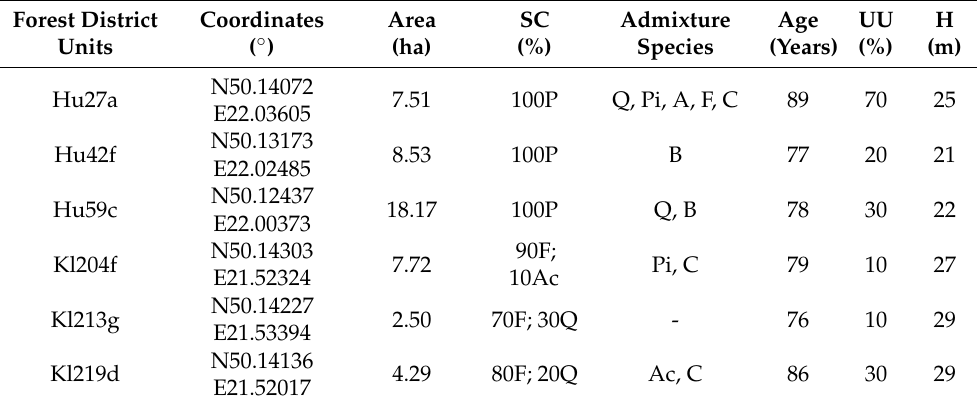
Table 1. Characteristics of stands parameters based on the forest management plan [46] and location of research